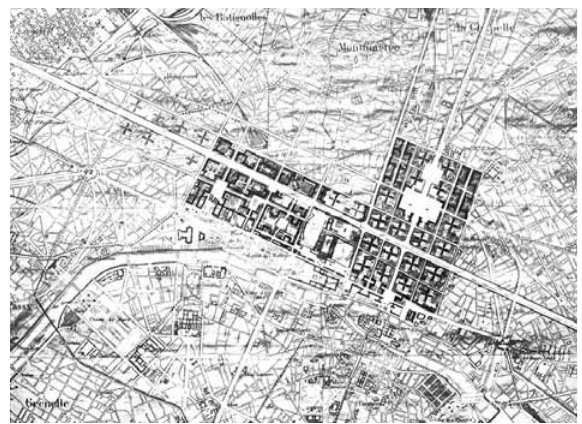
fig. 7. General floor plan of Plan Voisin. Version published in Gesamtes Werk 1929, p. 111 ©